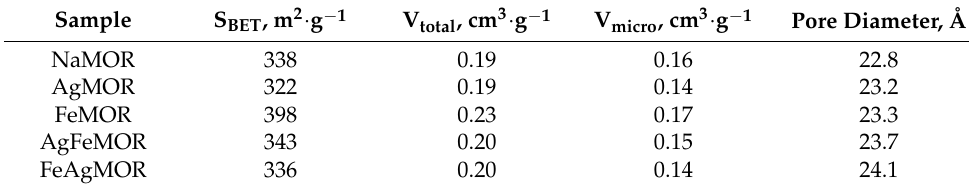
Table 1. Textural properties of the studied samples.